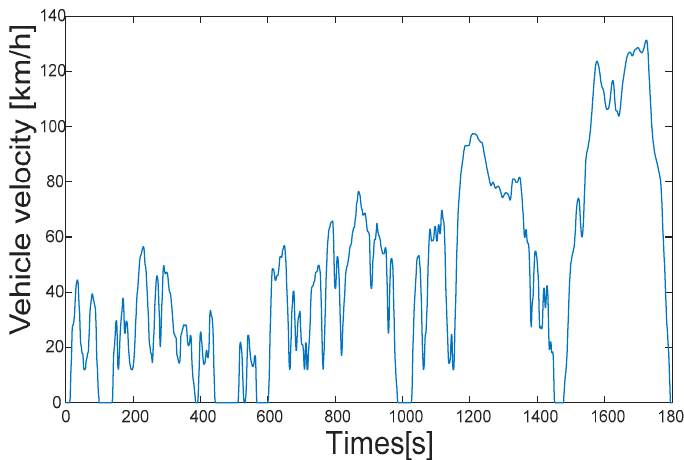
Figure 2. European standard cycle NEDC.